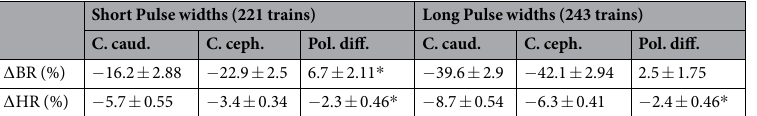
Left VNS (212 trains)